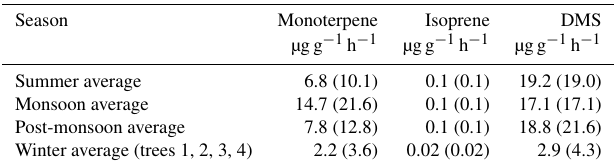
Table 2. Average seasonal BVOC emission fluxes from big-leaf ma- hogany in different seasons normalized to the leaf dry weight along with variability as standard deviation of the average in